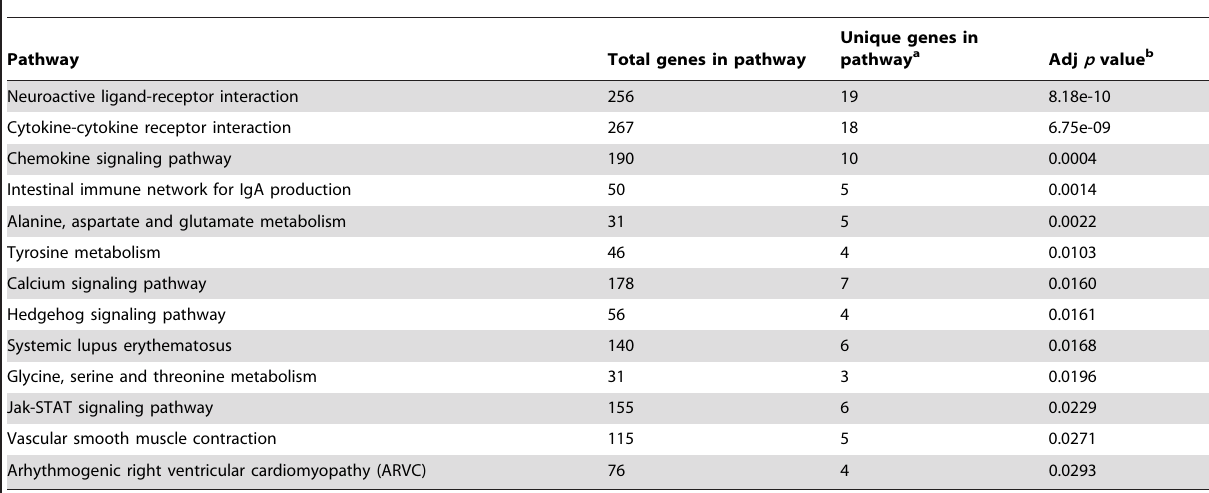
Table 2. Enriched regulated (KEGG) biological pathways among unique genes in periodontitis-affected tissues.